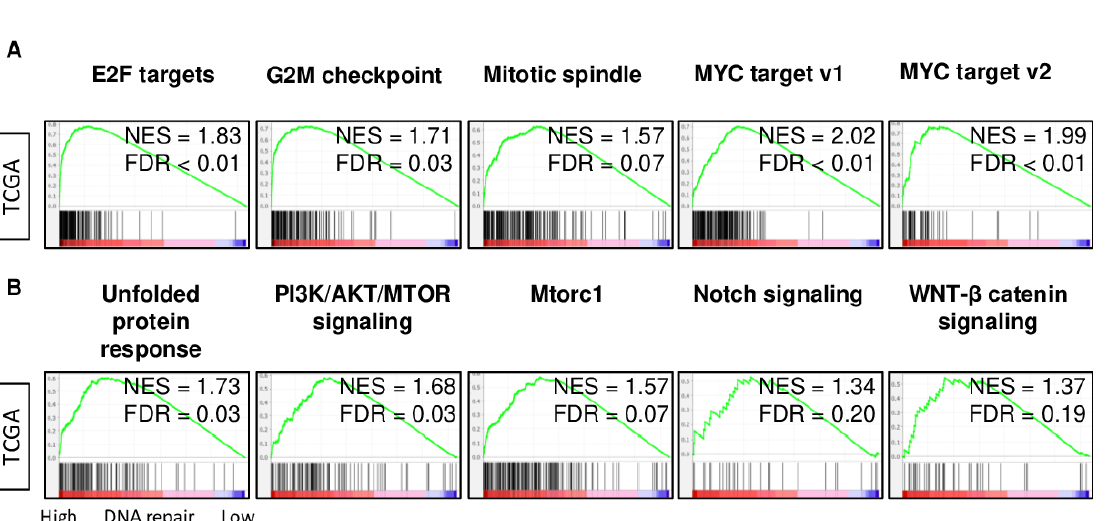
Figure 4. Gene set enrichment analysis (GSEA) of the Hallmark gene sets by high vs. low DNA repair score of HCC in the TCGA cohort. Enrichment plots along with the normalized enrichment score (NES) and false discovery rate (FDR) for ( A ) the proliferation-related gene sets, and ( B ) other gene sets of Hallmark gene sets. An FDR of 0.25 was used to deem statistical significance, as recommended by the GSEA software.